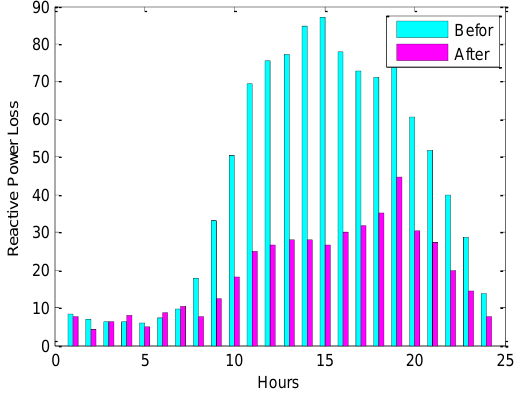
Figure 14. Reactive power losses for 24 h (first scenario).